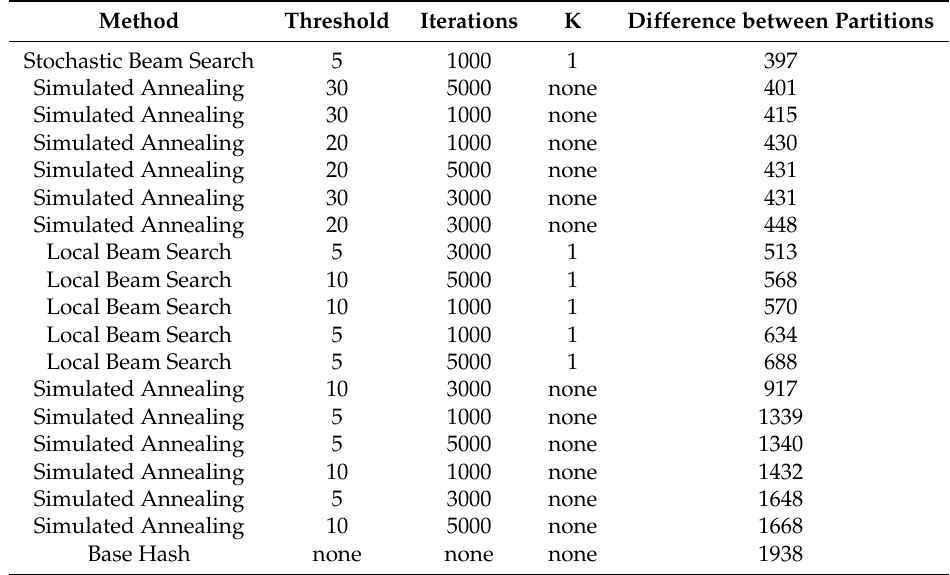
Table 2. Simulated Annealing compared to Base Hash and the worst Stochastic and Local Beam